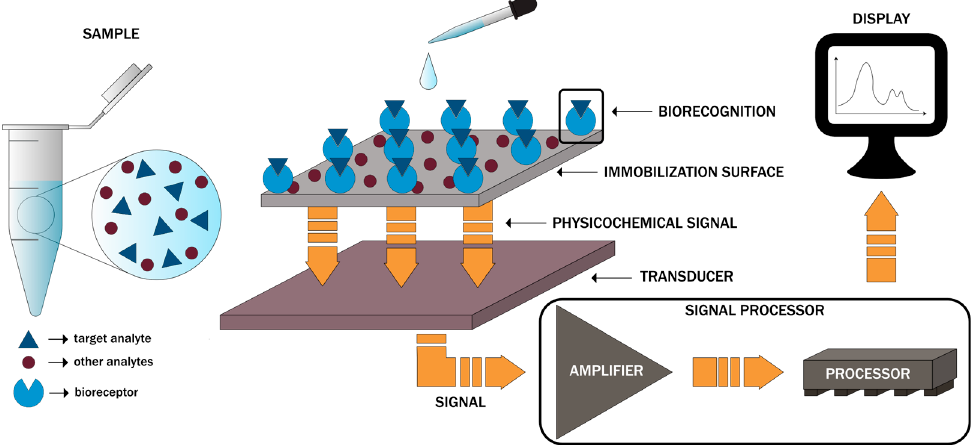
Figure 1. The main components of biosensors and the basic working principle.